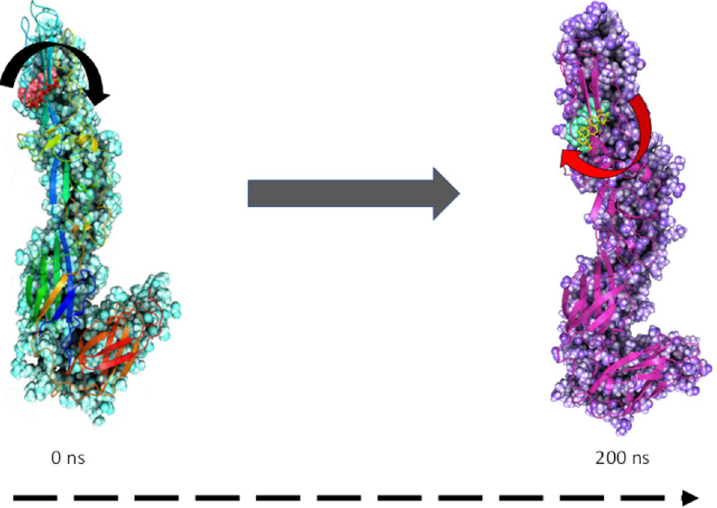
Fig 6. MMGBSA trajectory (0 ns, before simulation and 200 ns, after simulation) exhibited conformational changes of Lupenone upon binding with the protein 2ALA. The arrows indicating the overall positional variation (movement and pose) of Lupenone at the binding site